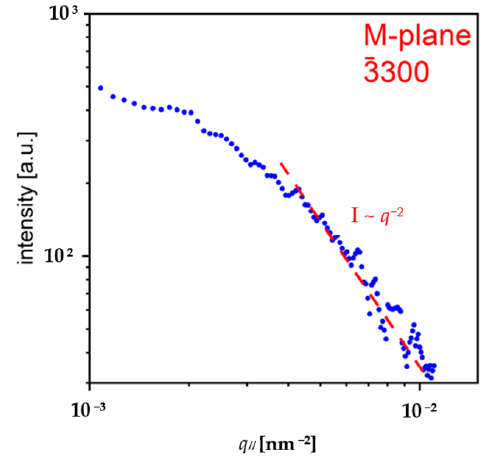
Figure A6. Log–log plot of the diffuse scattering intensity measured around the 3300 reflection on the (cid:0) (cid:1) m -plane slice. Huang diffuse scattering was identified since the intensity decreased according 1100 to I~ q − 2 (I—X-ray intensity, q —deviation of the scattering vector H from the reciprocal lattice vector